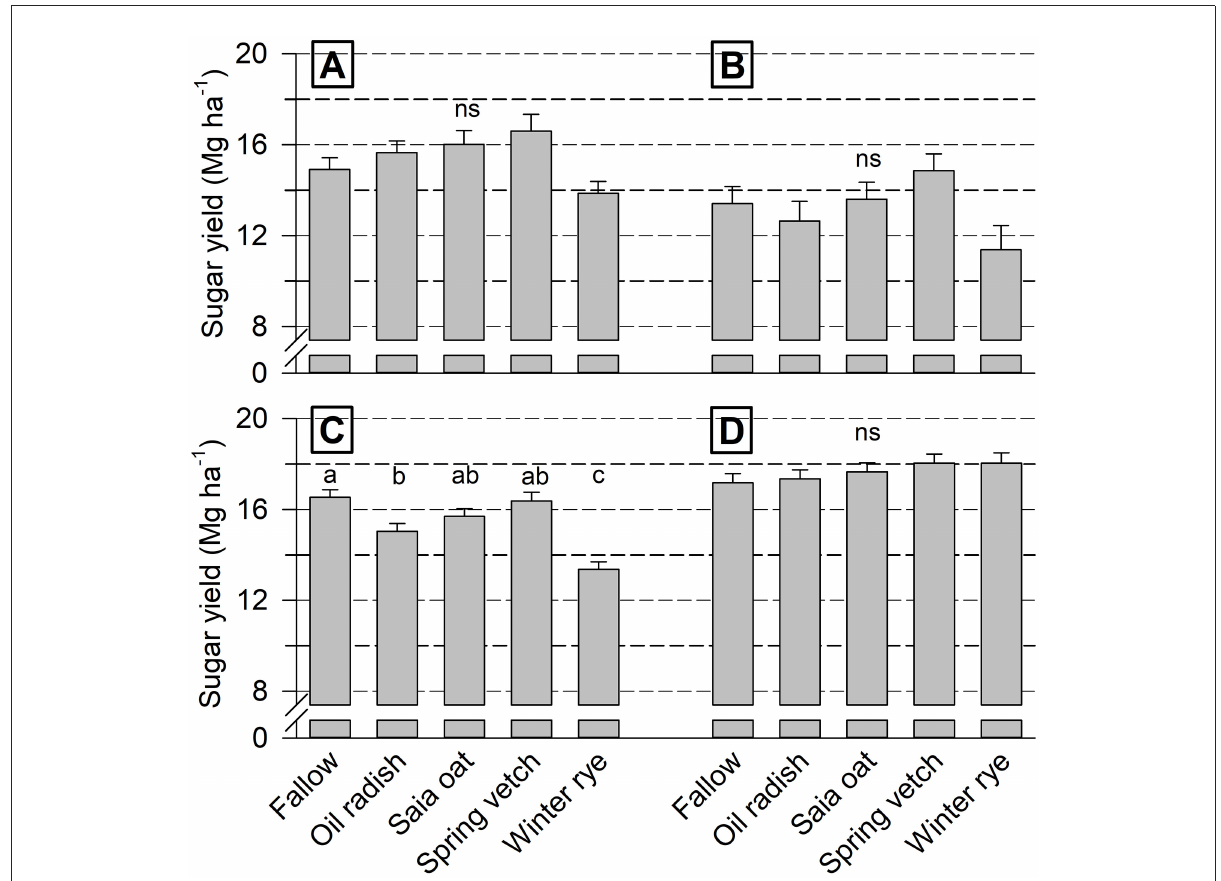
FIGURE3 Cover crop treatment effect on sugar yield of unfertilized sugar beet (mean of 4 replicates + standard error) at Ihinger Hof 2018/19 (A) and 2019/20 (B) , and Göttingen 2018/19 (C) and 2019/20 (D) . Different letters indicate significant differences among cover crop treatments within each site/year combination at p < 0.05 (Tukey-Kramer), ns not